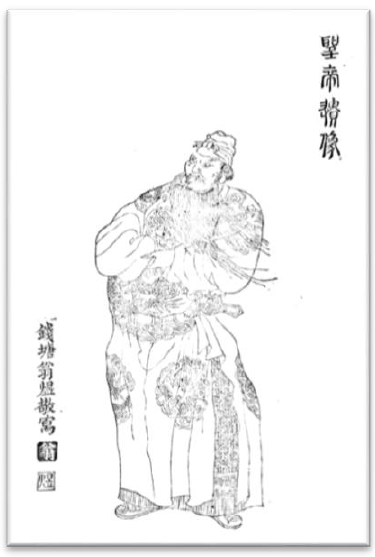
Figure 5. Thearch Kwan ( Complete Collection of Illustrated Records of Sacred Achievements of the Thearch Lord Sage Kwan [KJ] 1876, vol. 1, 1b).